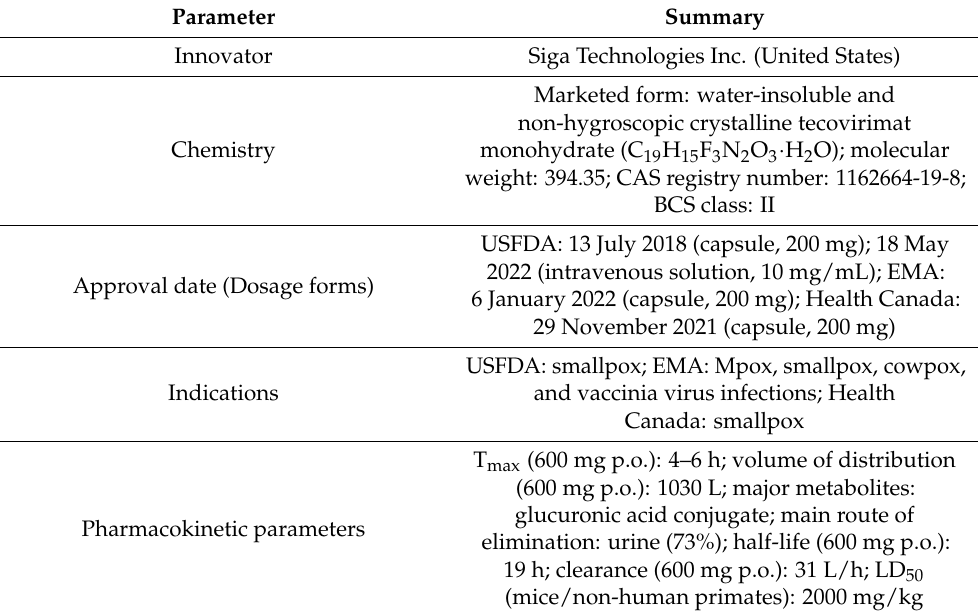
Table 4. Important information on marketed tecovirimat